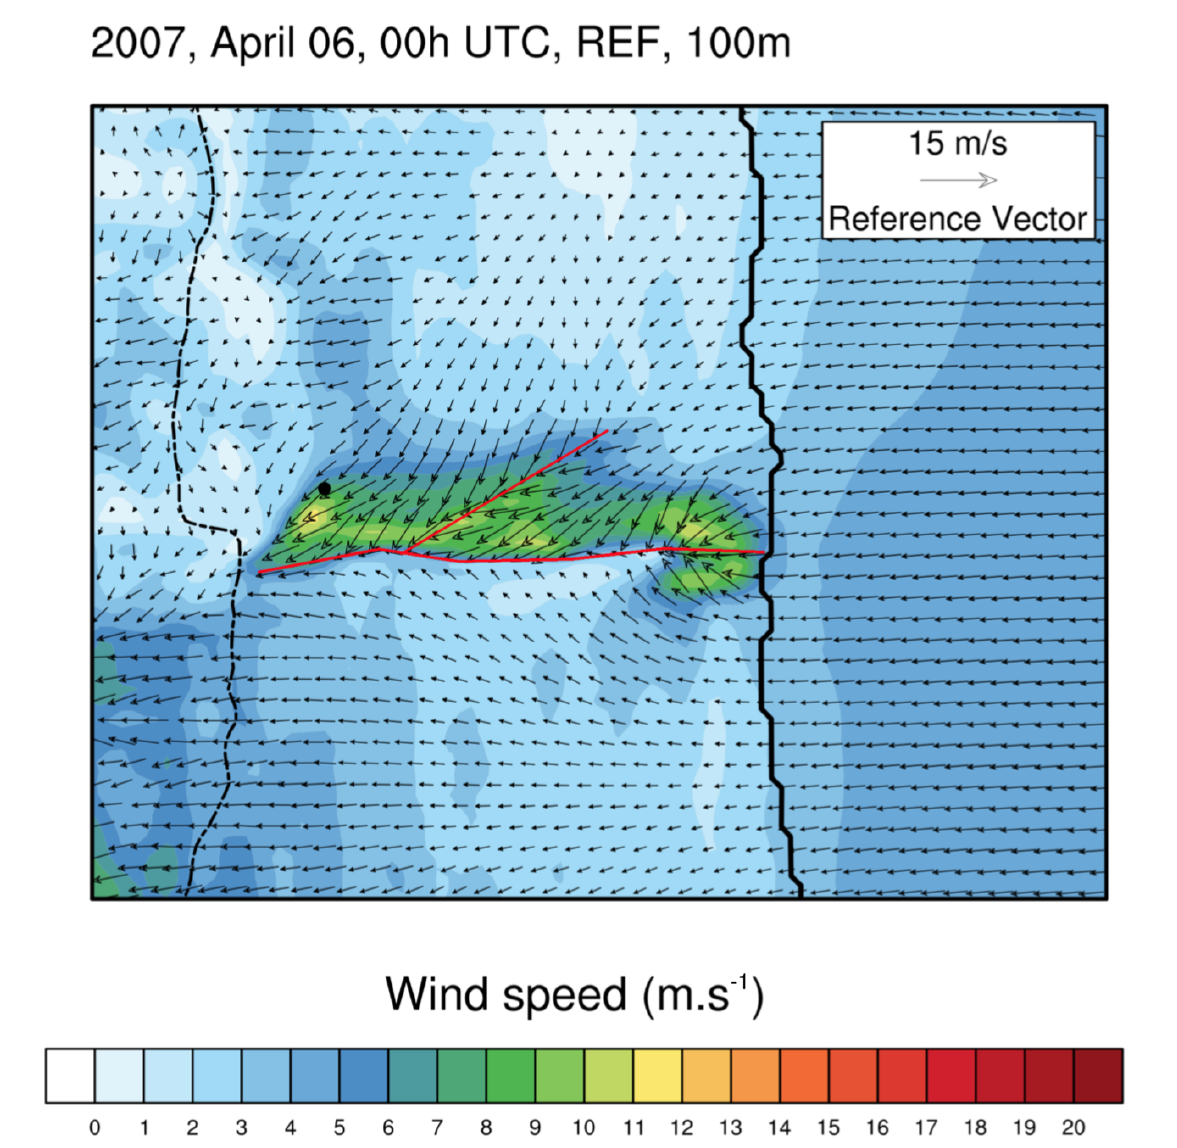
Figure 8. Simulated surface winds on 6 April 2007 convergence lines in